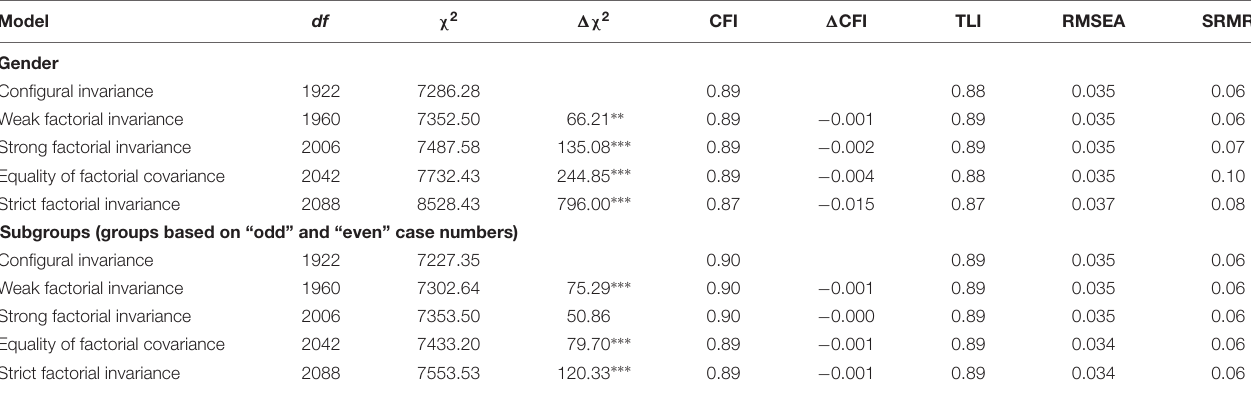
TABLE 7 | Model fit of various measurement invariance test models for gender and